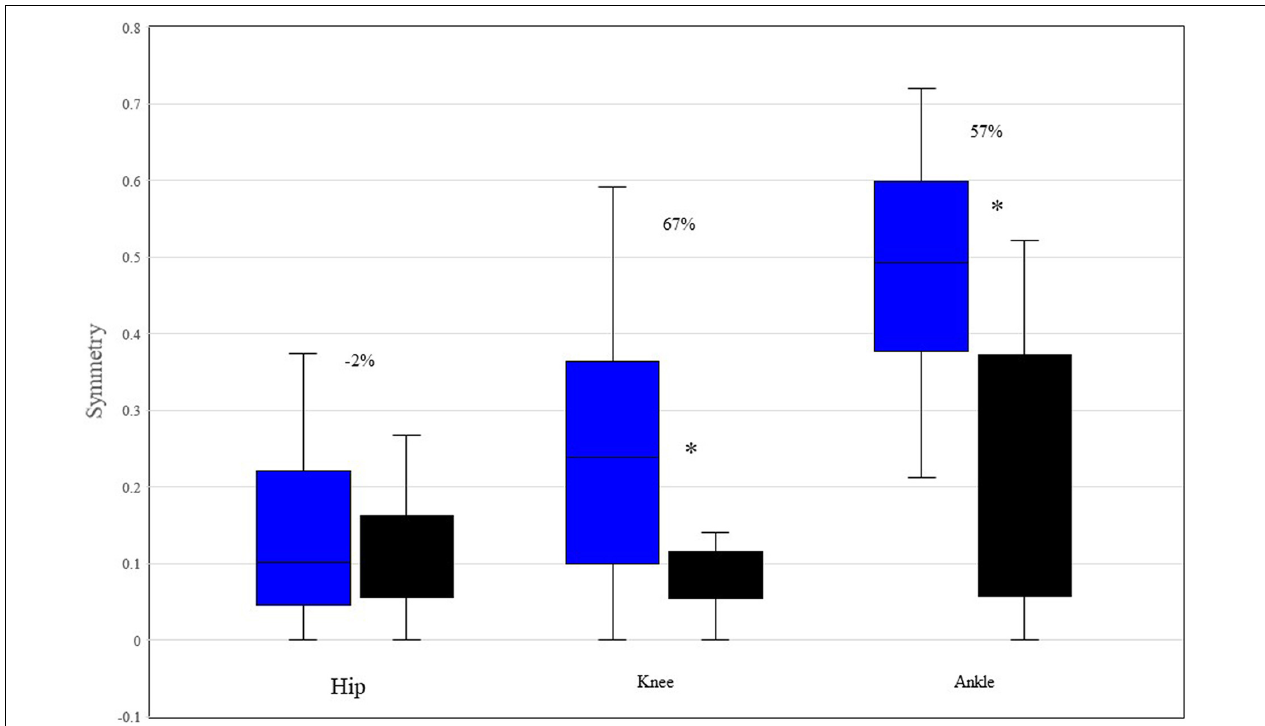
FIGURE 4 | Median and range symmetry values between the left and right ROM of hip, knee, and ankle, for each participant. ∗ Indicates p < 0.05 based upon Mann-Whitney testing. The percentages reflect the differences between P1 and P2. P1 is represented by blue boxes, P2 by black boxes.